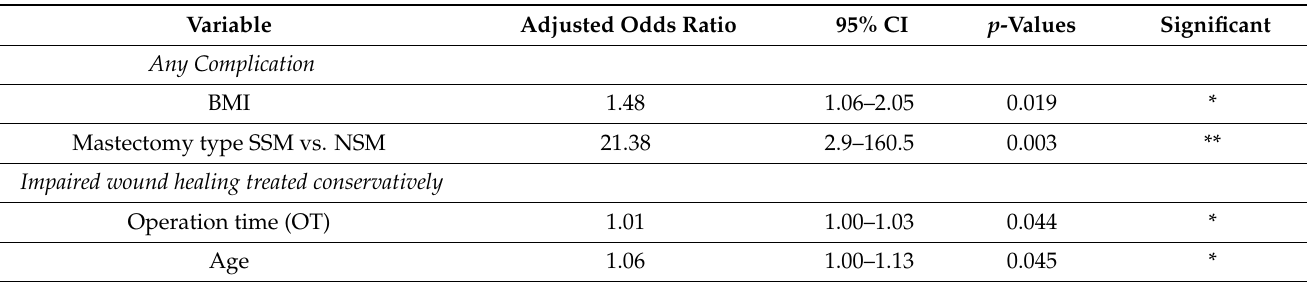
Table 7. Multifactorial Binary Logistic Regression Analysis with Adjusted Odds Ratios for Indepen- dent Predictors per Dependent